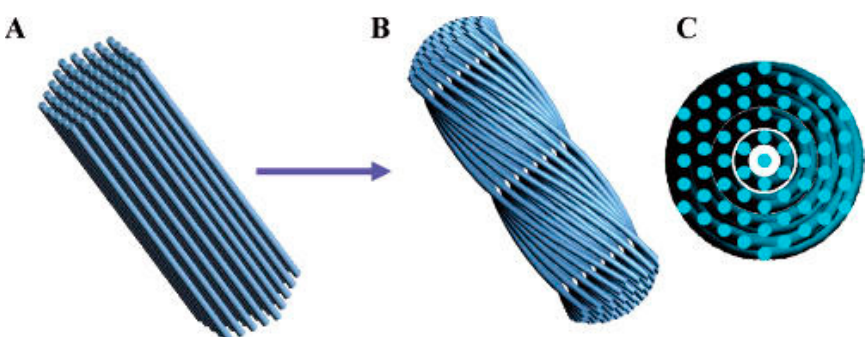
Figure 5. Schematic drawing illustrating the formation of helical mesostructured rods from hexagonally arrayed straight rod-like micelles with equal length ( A ) to a helical rod with two rounded ends viewed perpendicular to the length direction ( B ) and the hexagonal cross-section viewed parallel to the length direction ( C ). Credit: reprinted with permission from [44]. Copyright 2006 American Chemical Society.